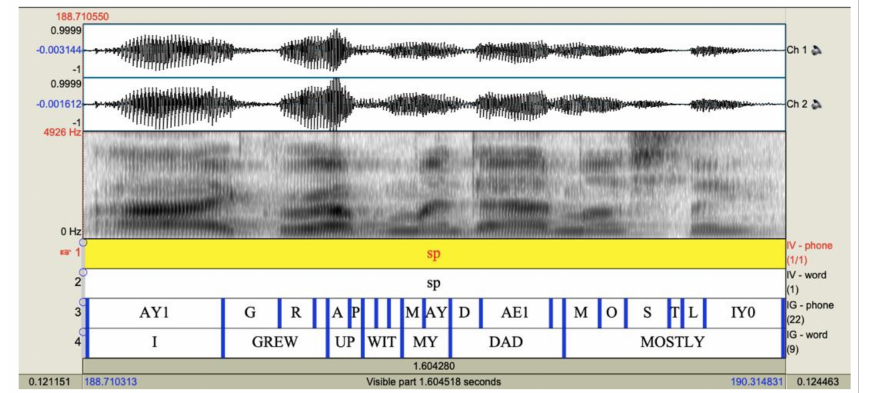
Figure 1. An illustration of the Praat window (“sp” refers to “silent pause”; Ch1 and Ch2 refer to Channel 1 and Channel 2, respectively, which indicate the stereo mode of recording; IV, short for Interviewer; IG, short for “Isiah Goodson”, which is the pseudonym of this participant). To sum up, the final dataset included the audio files and the corresponding TextGrid files (containing multi-level annotations including utterance, word, and phone such as vowels and consonants). The data collection and processing procedure is schematically illustrated in Figure 2.